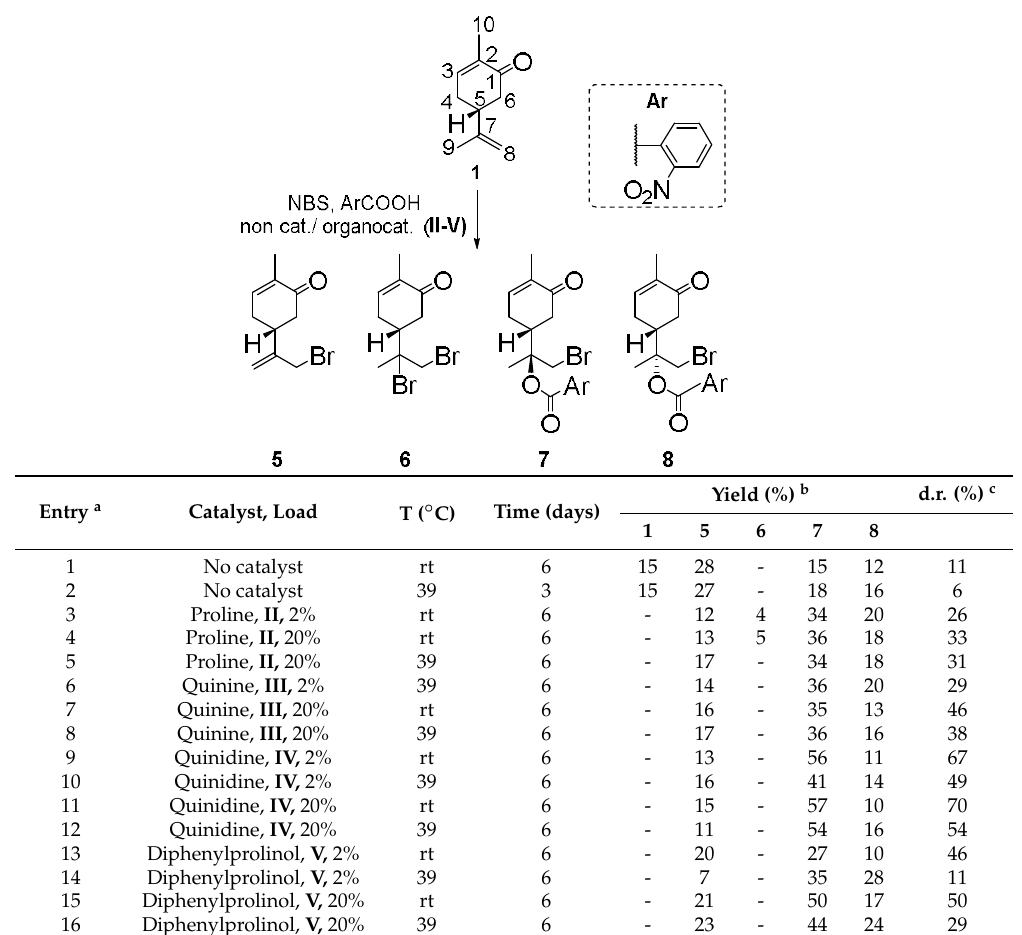
Table 1. Organocatalyst scope and optimization of reaction conditions for the synthesis of the bromoesters 7 and 8 .